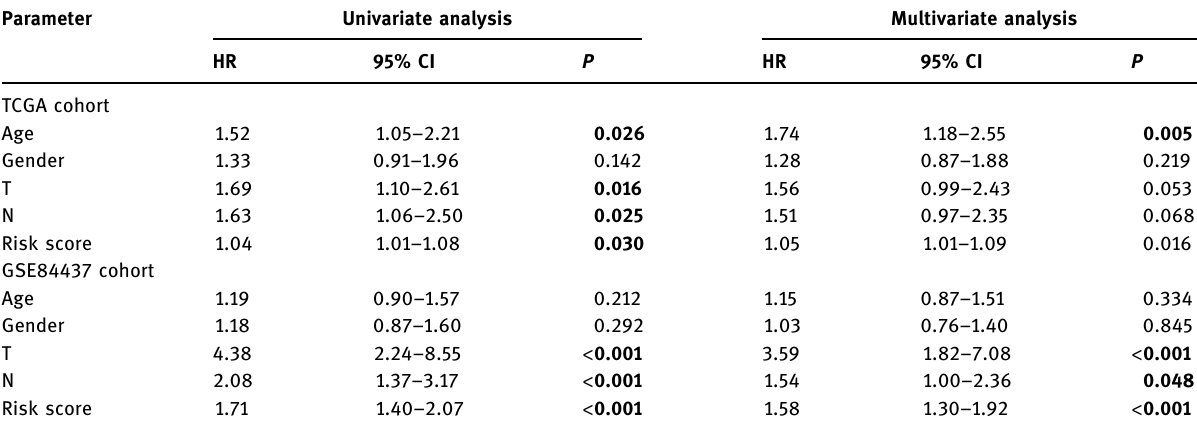
Table 2: Univariate analysis and multivariate analysis of the correlation of nine immune - relevant genes ’ signature with OS among GC patients Parameter Univariate analysis Multivariate analysis